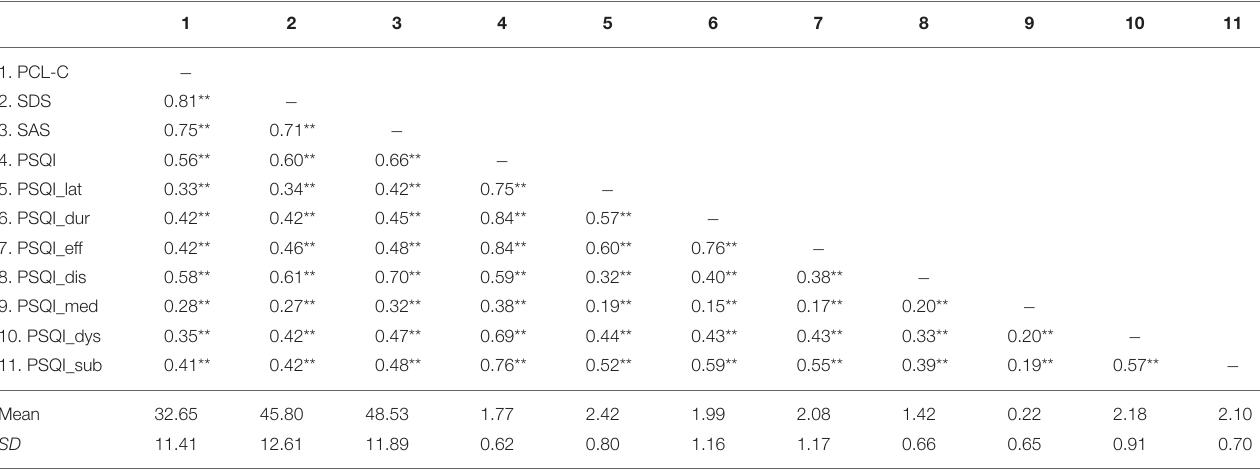
TABLE 5 | Descriptive statistics and zero-order correlations for all measures for PCL-C, SDS, SAS, and PSQI Scores.